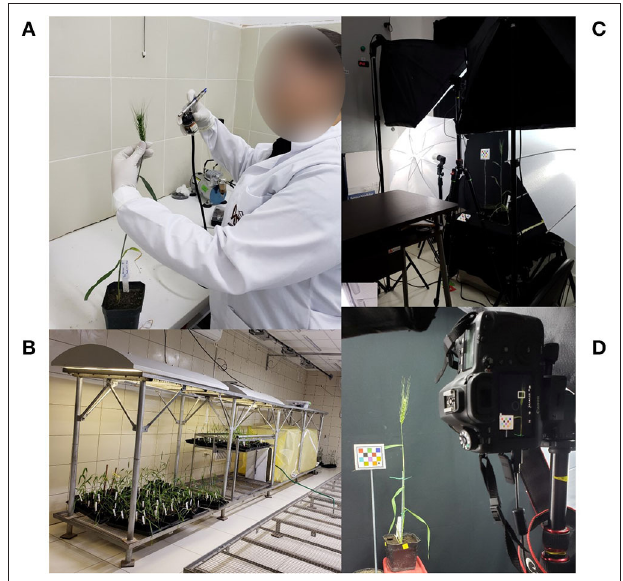
FIGURE 1 | Wheat blast image collection flow process: (A) Magnaphorthe oryzae pathotype Triticum inoculation, (B) After inoculation, plants were moved to the yellow dew chamber that provided optimal conditions for fungal infection for 48h, later transfer to the black trays, (C) wheat spike imaging set up, and (D) an image was captured perpendicular to the